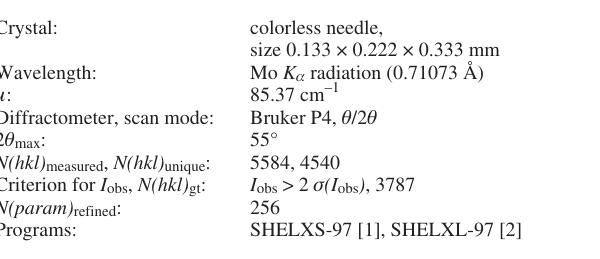
Table 1. Data collection and handling.